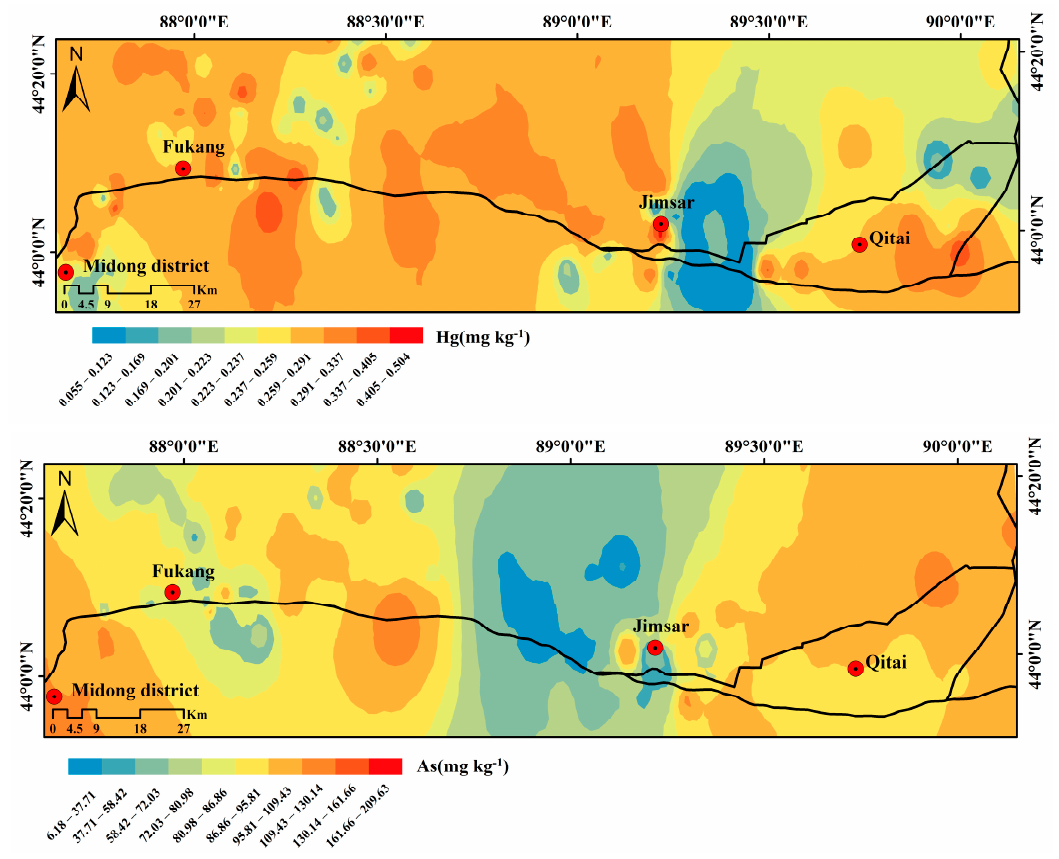
Figure 2. Spatial distributions of soil heavy metals.